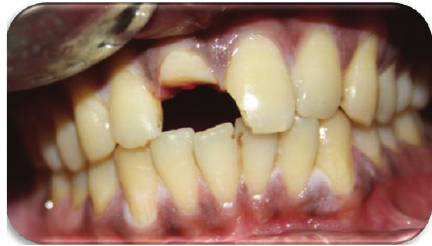
Figure 3: After fragment